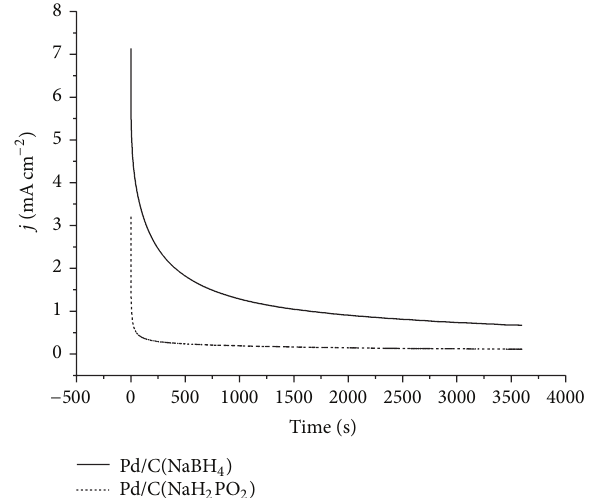
Figure 5: Chronoamperometry curves of Pd/C (NaBH 4 ) and Pd/C (NaH 2 PO 2 ) in 1mol ⋅ L −1 C 2 H 5 OH + 1mol ⋅ L −1 KOH solution at a fixed potential of − 300mV for 3600 s.